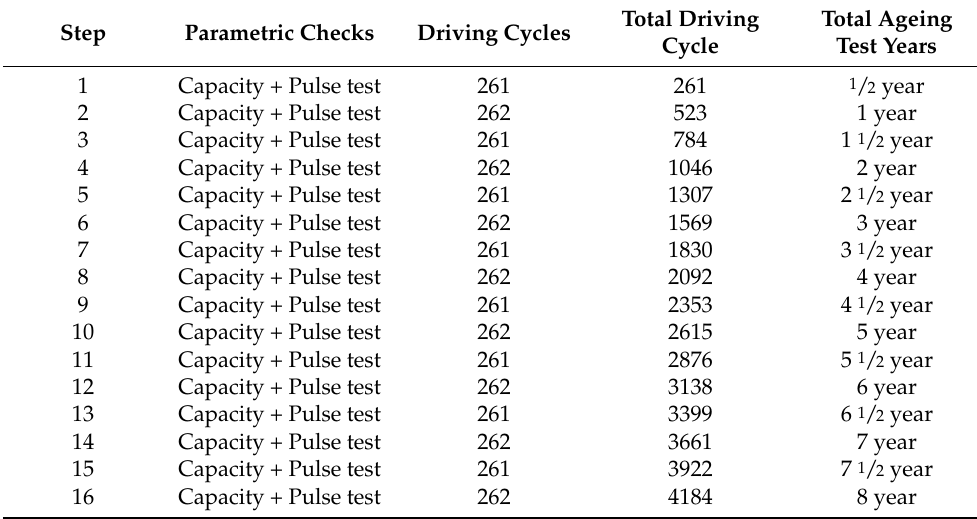
Table 8. Ageing test with WLTP CLASS 3B driving cycle.